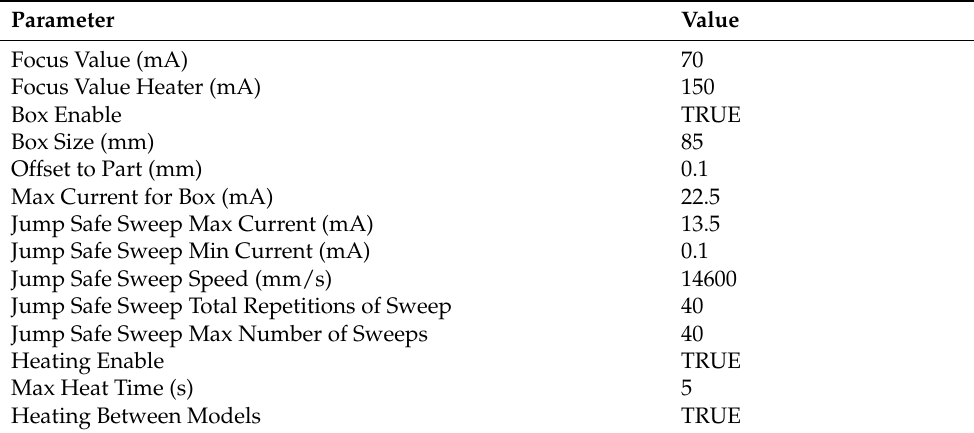
Table 3. EB-PBF preheat parameters used to fabricate the specimens used in this study (the parameters shown are specifically those that have been modified from the standard commercial parameter sets for Ti6Al4V, V3.2